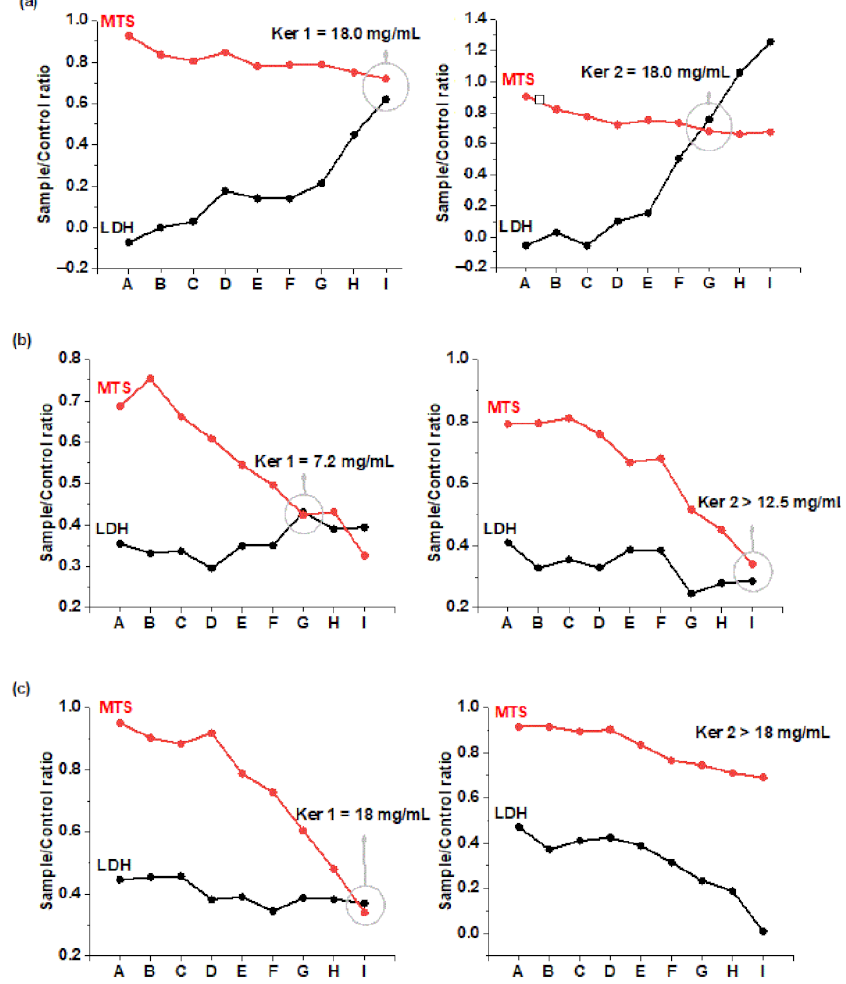
Figure 5. Cytotoxic profile of Ker 1 and Ker 2 on: ( a ) dermal fibroblasts (HS27); ( b ) keratinocytes (Ha- CaT); ( c ) endothelial cells (HUVEC). The sample concentrations were: A: 0.6 mg/mL, B: 3.0 mg/mL,